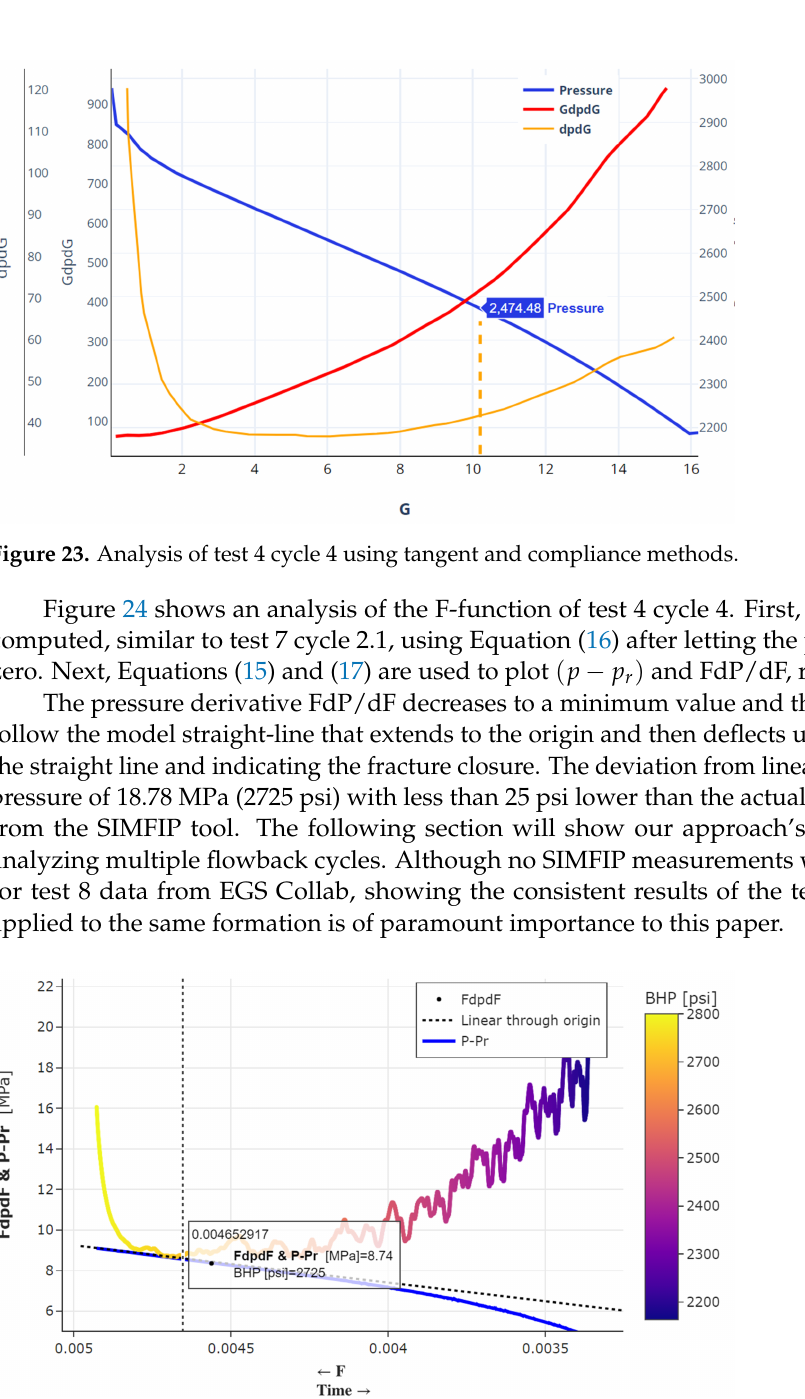
Figure 24. F-function of the shut-in test 4 cycle